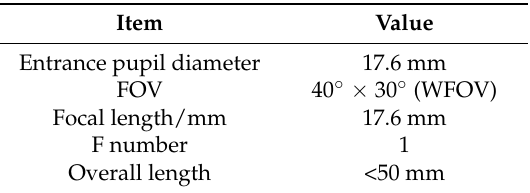
Table 2. Parameters of optical